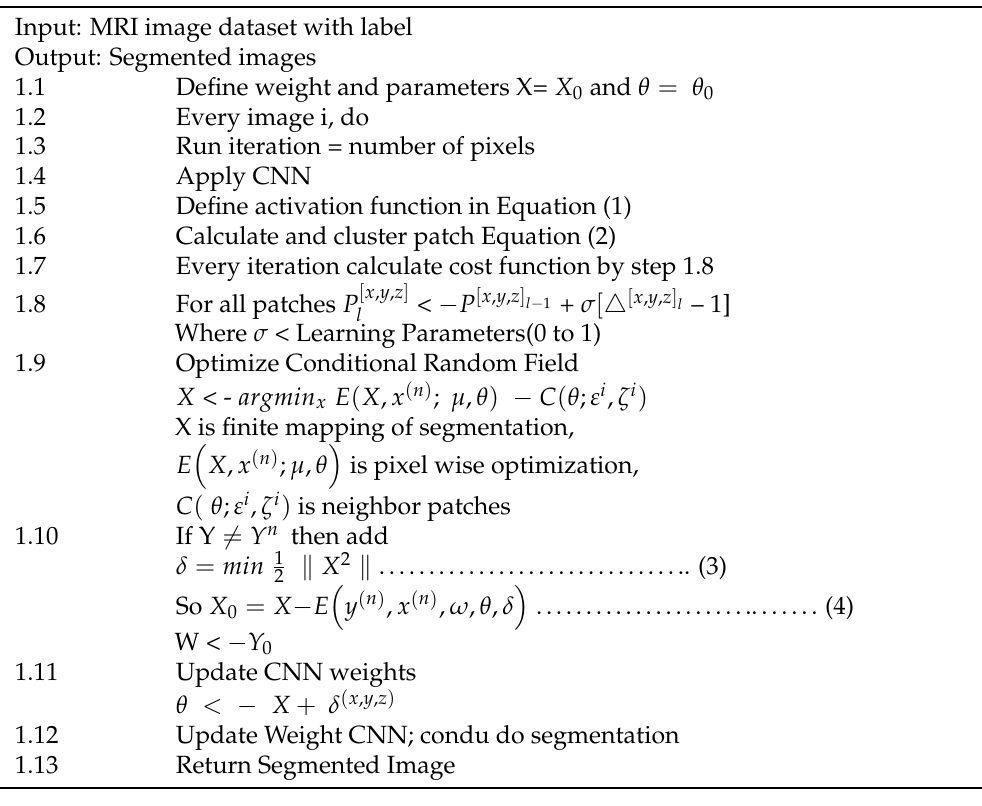
Algorithm 1: Conditional-Conv segmentation.